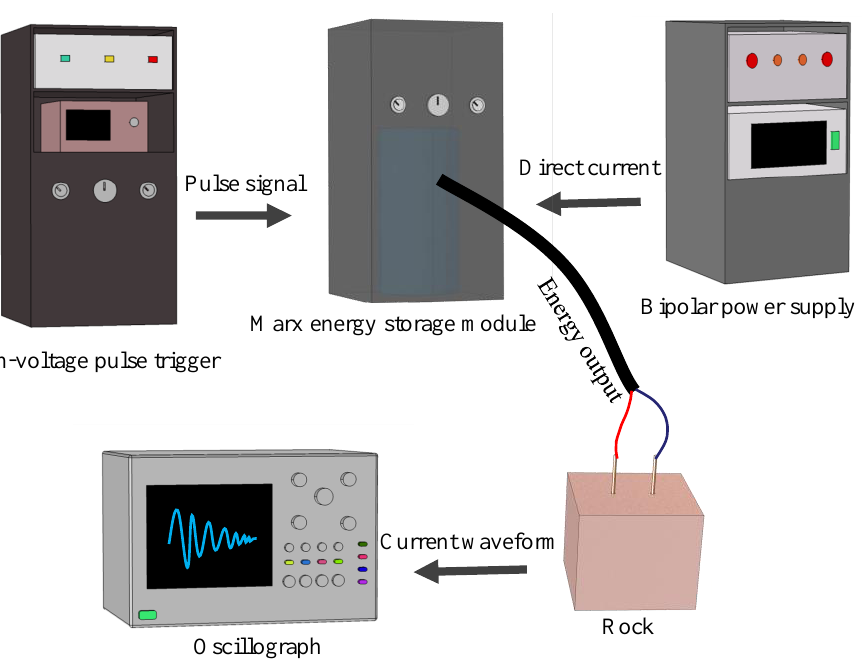
Figure 2. Workflow of the PHVD device.